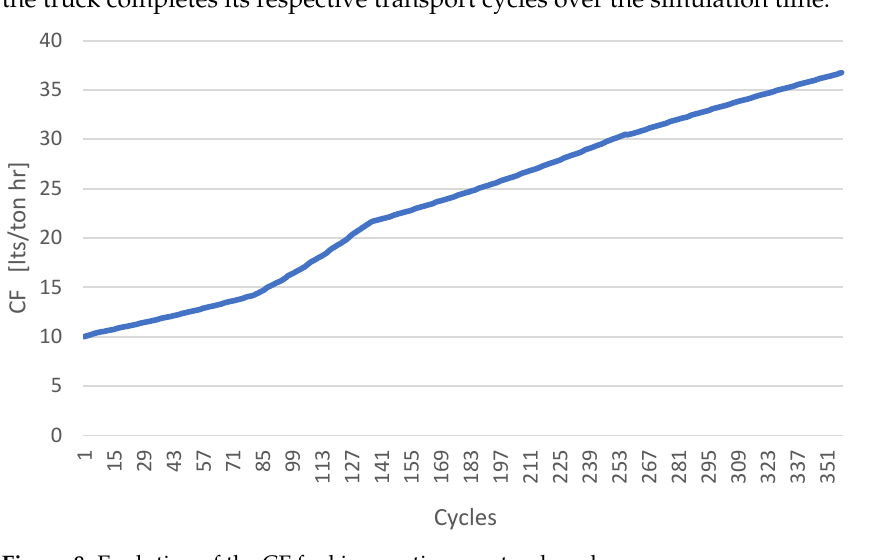
Figure 8. Evolution of the CF fuel in a section as a truck cycles.